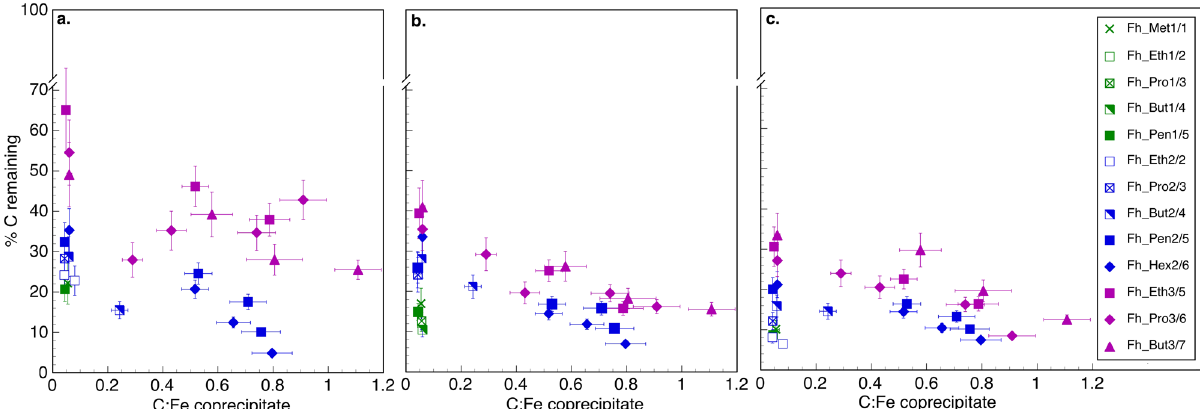
Fig. 4 Desorption and chemical stability of mono-, di- and tri-carboxylic acids coprecipitated with iron (oxyhydr)oxide ferrihydrite. Desorption and chemical oxidation data for carboxylic acid ferrihydrite coprecipitates plotted as C:Fe molar ratio coprecipitate vs. percent C remaining after treatment: a exposure to arti fi cial seawater, b exposure to 0.1 M NaOH, and c oxidation with 1 M NaOCl. Green, blue and purple colour codes depict mono-, di- and tri- carboxylic data, respectively. The coprecipitate nomenclature is given in Fig. 1. Symbols are as follows: cross: Fh_Met1/1; open square: Fh_Eth1/2 and Fh_Eth2/2; crossed open square: Fh_Pro1/3 and Fh_Pro2/3; half solid square: Fh_But1/4 and Fh_But2/4; solid square: Fh_Pen1/5, Fh_Pen2/5 and Fh_Eth3/ 5; solid diamond: Fh_Hex2/6 and Fh_Pro3/6; solid triangle: Fh_But3/7. Data points and error bars represent the mean and one standard error of the mean (1 SEM) for triplicate coprecipitates each measured in triplicate ( X axis), and the mean and one standard error of the mean (1 SEM) for triplicate coprecipitates each desorbed or chemically oxidised in triplicate and measured in triplicate ( Y axis). Errors are propagated through all calculations using standard error propagation rules.